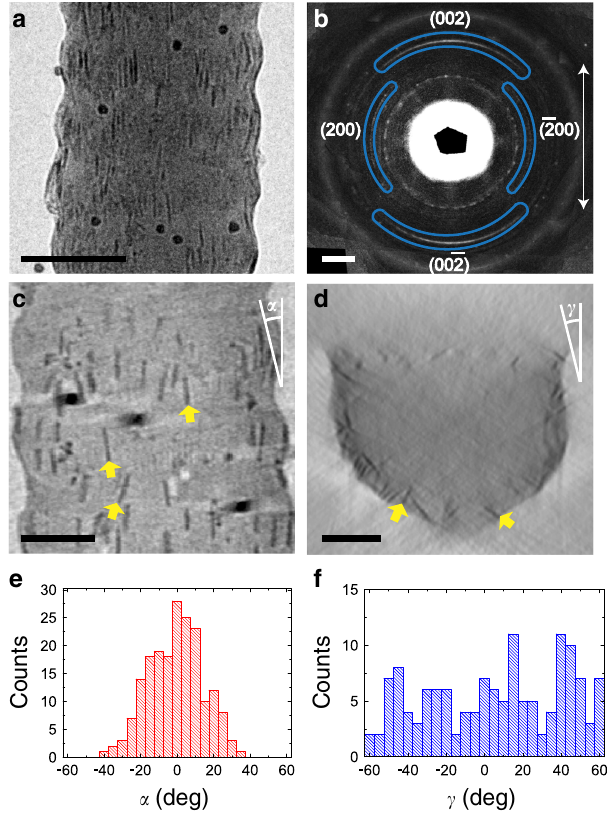
Fig. 4 Type I collagen fi bril mineralized with γ -FeOOH in the presence of pAsp. a TEM image of a collagen fi bril containing γ -FeOOH platelets. b LDSAED of a showing wide arcs of γ -FeOOH (002) diffraction along the collagen fi bril axis. The pattern is obtained after radial alignment and averaging of 9 individual patterns (see Supplementary Figs. 13 and 14, and Supplementary Table 1). The direction of the collagen fi bril long axis is highlighted by the white arrow. c , d Tomographic reconstruction y - and z -slices, respectively. d Is averaged from 10 adjacent slices to enhance the contrast. The orientations of some γ -FeOOH platelets are highlighted by yellow arrows in c , d . e , f Longitudinal and lateral angular distribution ( α and γ , as indicated in c and d ) of the platelets, respectively. ~150 crystals were measured that were at least 10 nm apart for e and 50 nm apart for f .